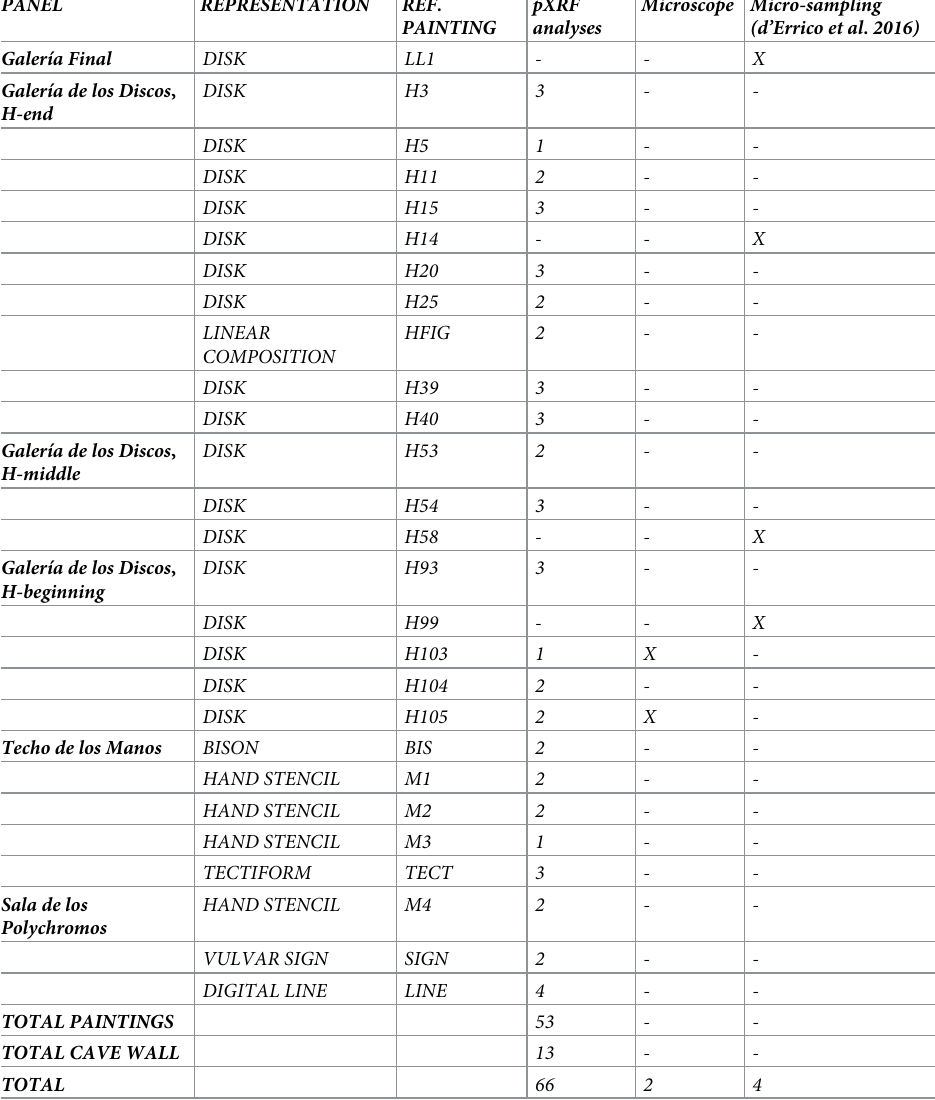
Table 2. List of the paintings analysed, type of analyses performed and number of pXRF spectra used in the pres- ent study.